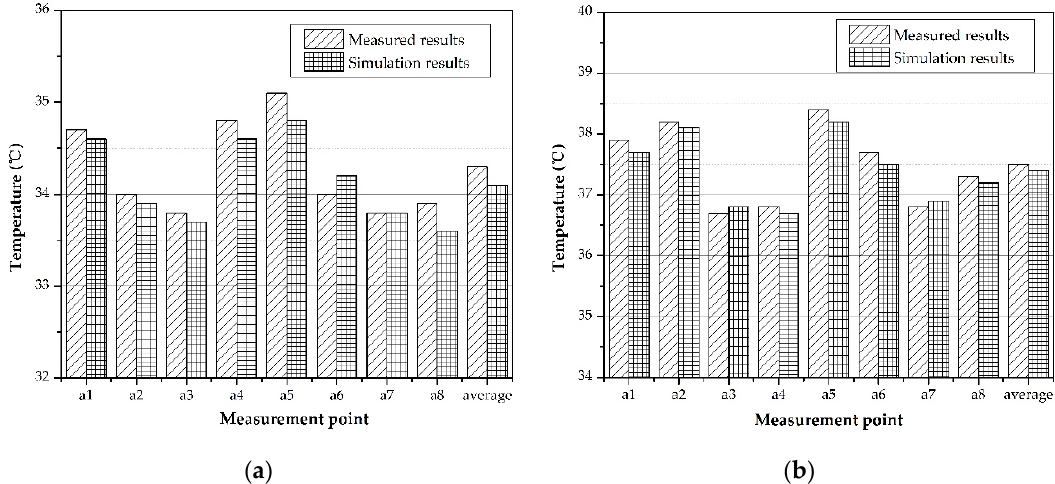
Figure 12. Comparison between the measured data and the simulation results without and with LHD: ( a ) without LHD; and ( b ) with LHD.